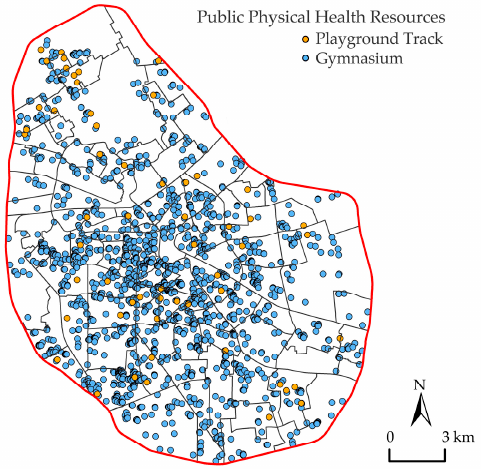
Figure 4. Spatial distribution of public physical health resources in the research area.